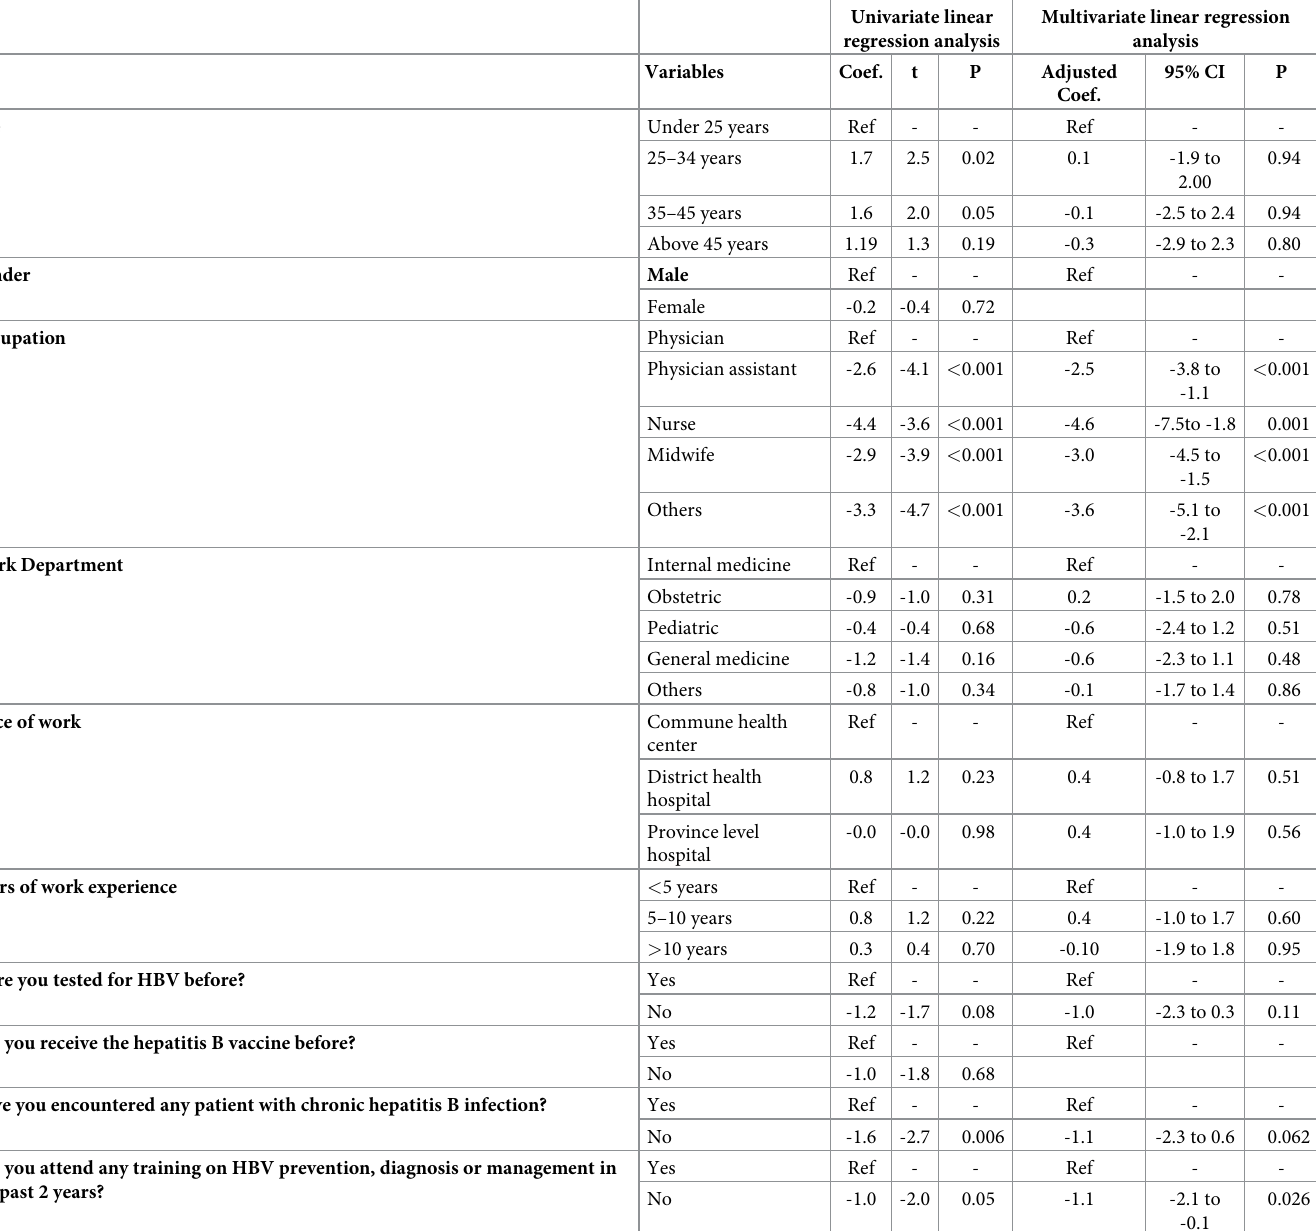
Table 5. Analysis of factors associated with HBV total knowledge score (N =